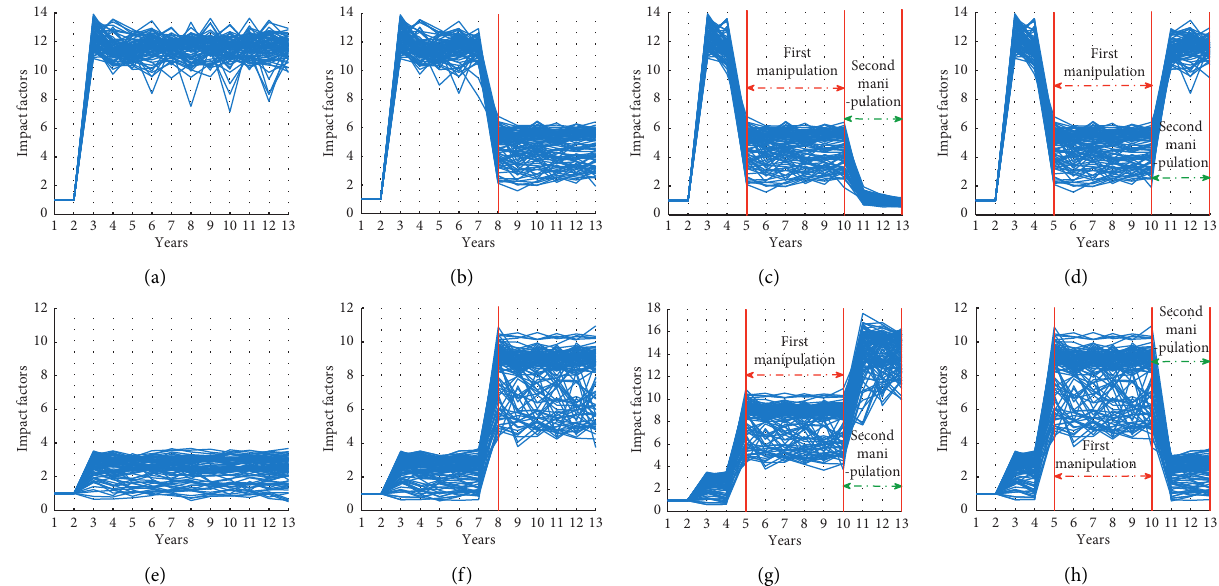
Figure 8: Comparison of the normal JIF and manipulated JIF in 100 Monte Carlo simulation runs. (a) Normal impact factors within 13 years. (b) Impact factors with one manipulation. (c) Impact factors with two manipulations. (d) Impact factors with two manipulations. (e) Normal impact factors within 13 years. (f) Impact factors with one manipulation. (g) Impact factors with two manipulations. (h) Impact factors with two manipulations. Table 1: Model parameters, baseline values, variation intervals, and step of variation for probabilistic sensitivity analysis.